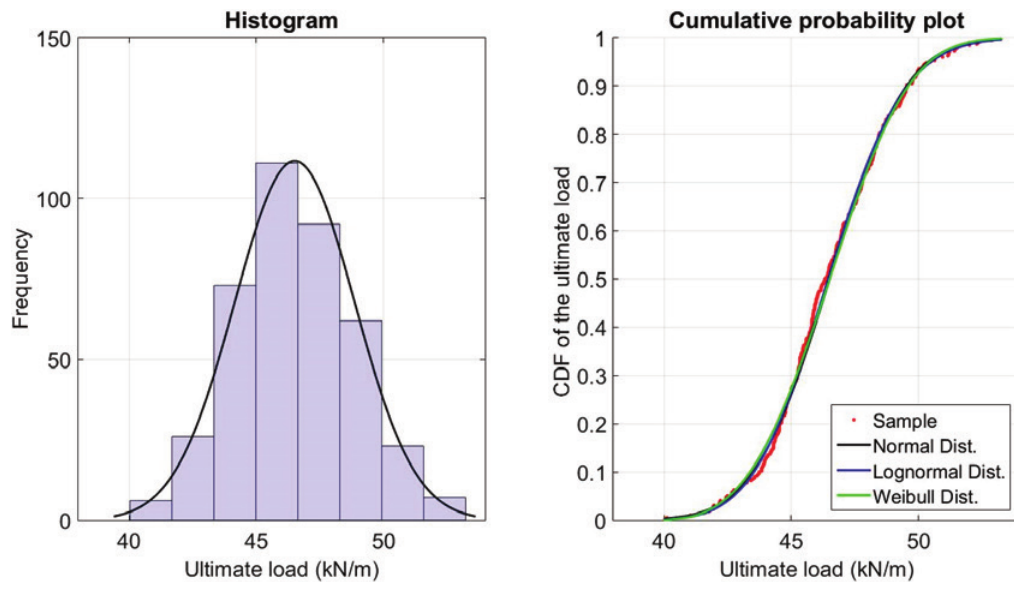
Distributions fitness for resistance of the beam V-25-40-r-25 (400